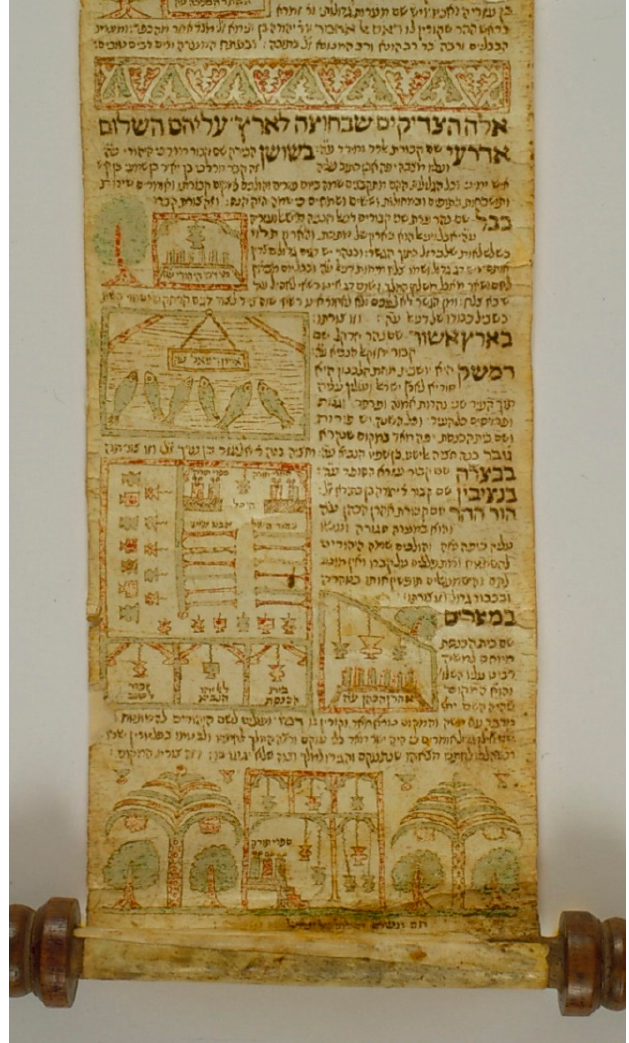
Figure 7. Jerusalem, National Library, The Scroll of Yihus ha-Avot from the Land of Israel, first half of the 16th century, Ms. Heb. 38.1187, used with permission from the National Library of Israel.